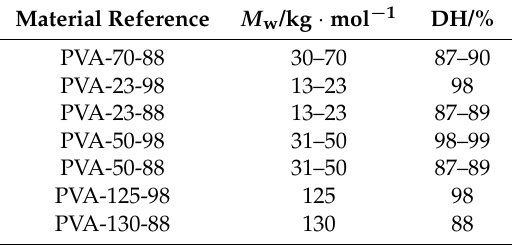
Table 1. Details of PVA resins used for positron annihilation